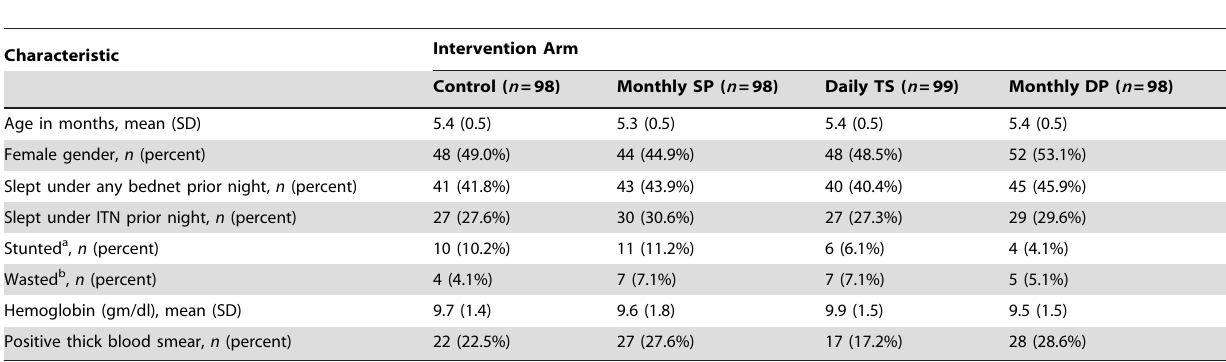
Table 1. Baseline characteristics at enrollment of study participants randomized to the intervention.